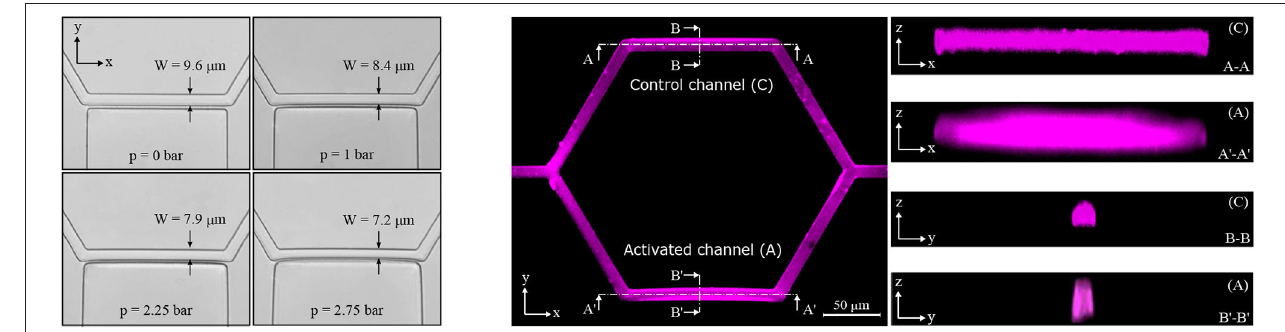
FIGURE 3 | Activated channel deformation. Deformation of the activated channel in the plane XY upon the inflation of the pressure chamber (left) . Four pictures are shown starting from the baseline configuration at p 0.16 µ m / pixel ). Fluorescence images for the single-mesh network upon the inflation of the pressure chamber ( p Images in the z direction show differences between the control channel (C) and the activated channel (A).